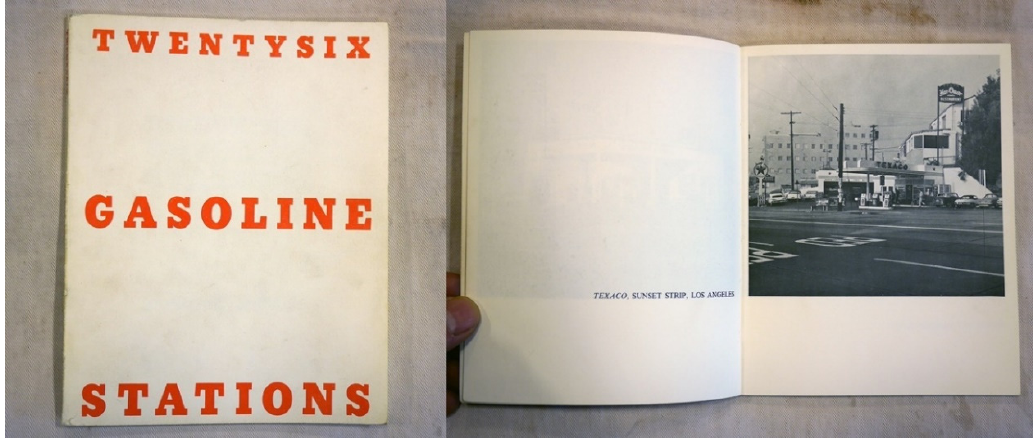
Figure 1. Edward Ruscha, Twentysix Gasoline Stations , 1963. Courtesy of Arnolfini and Bristol Archives.